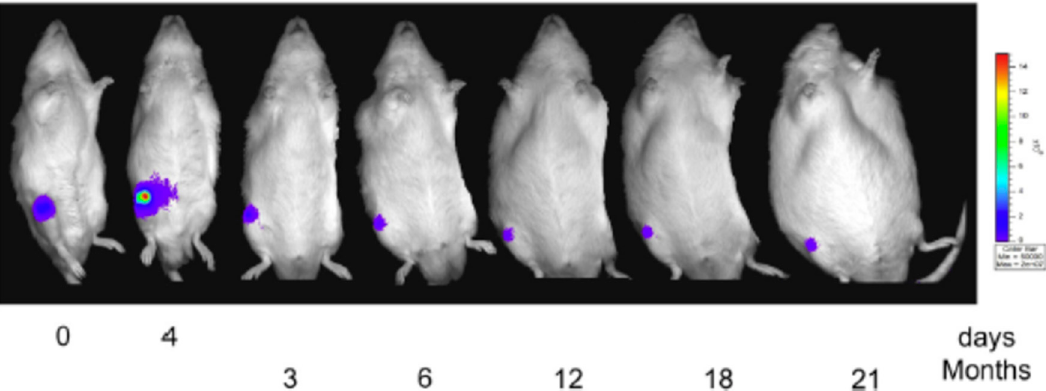
Figure 6. CCD images from the long-term observation of luciferase activity from the right knee joint. This representative image shows the CCD image of one rat from the AC-SY group (transplanted with chondrocyte and synovial cell sheets) at the following time points (from left to right): after transplantation on day 0 and day 4, and at 3, 6, 12, 18, and 21 months. The color bar indicates the bioluminescence intensity in photons per seconds cm 2 per steradian. Reproduced with permission from [80].